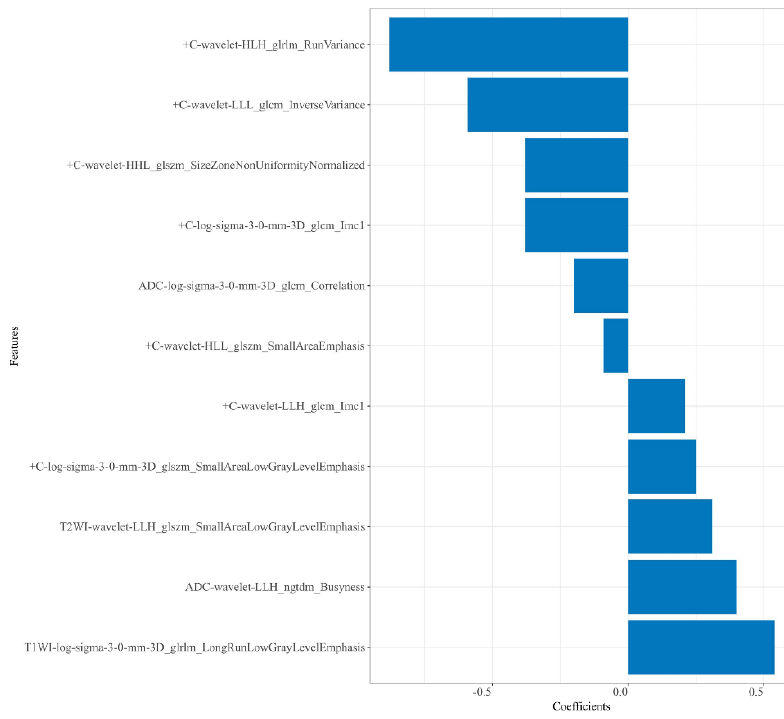
Figure 3. Plot of regression coefficients for retained radiomics features.